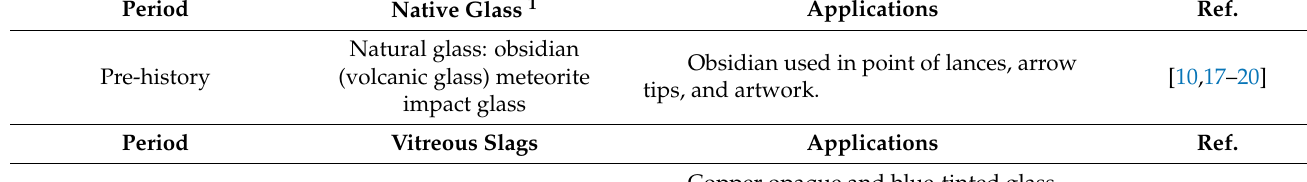
Table 1. Breakthrough in glass melting-quenching technology (first generation on glass